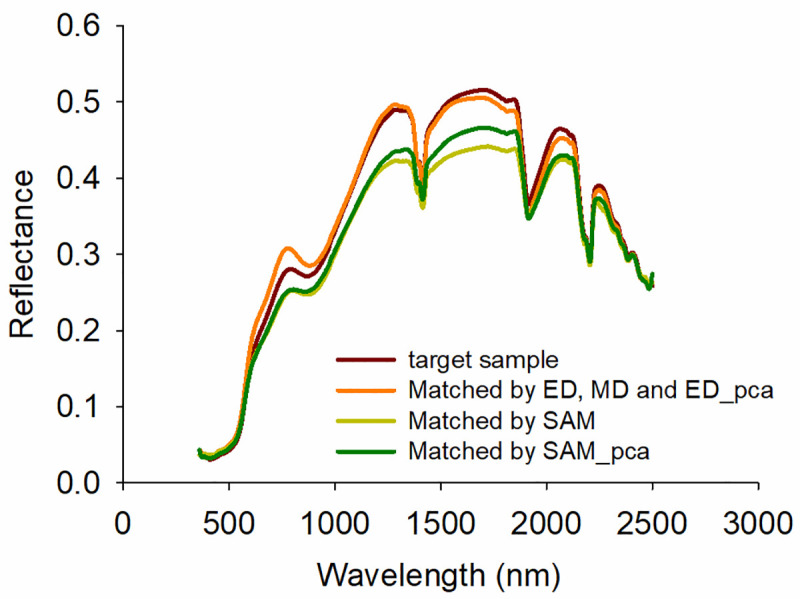
An illustrative example of the most similar spectra selected by the five similarity indices.